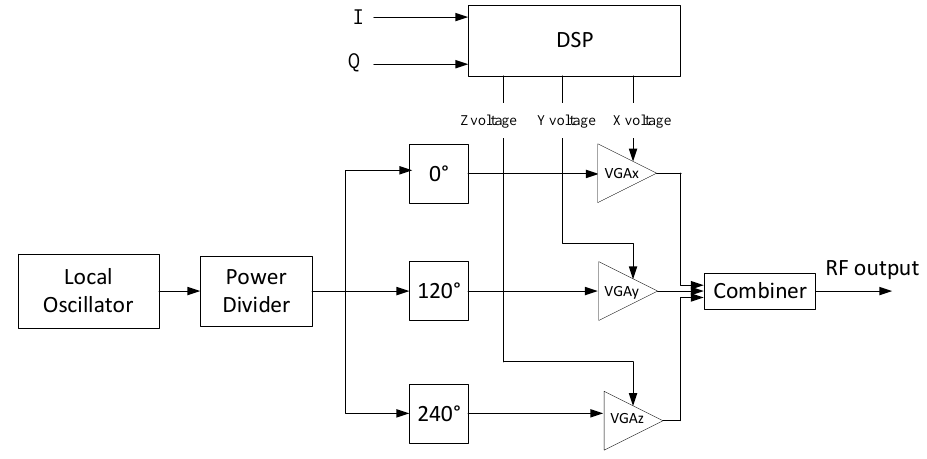
Figure 2. High-level block schematic of the mixer-less three-way amplitude modulator-based transmitter.